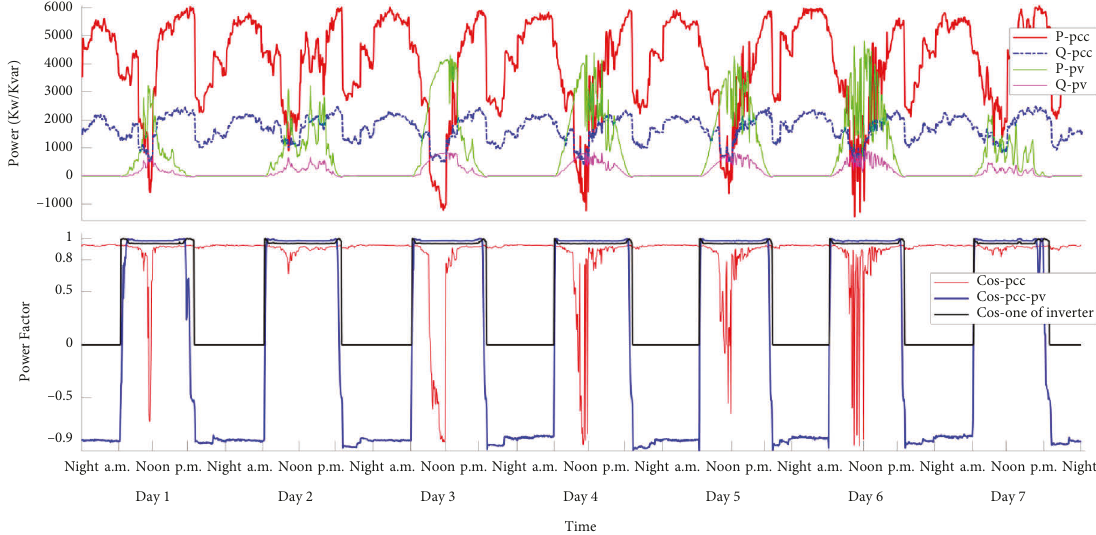
Figure 2: PF comparison diagram of PVPS without